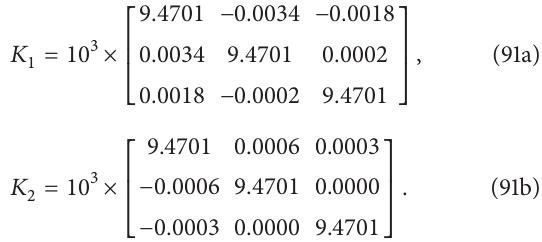
Figure 8: Membership functions of the fuzzy controller.